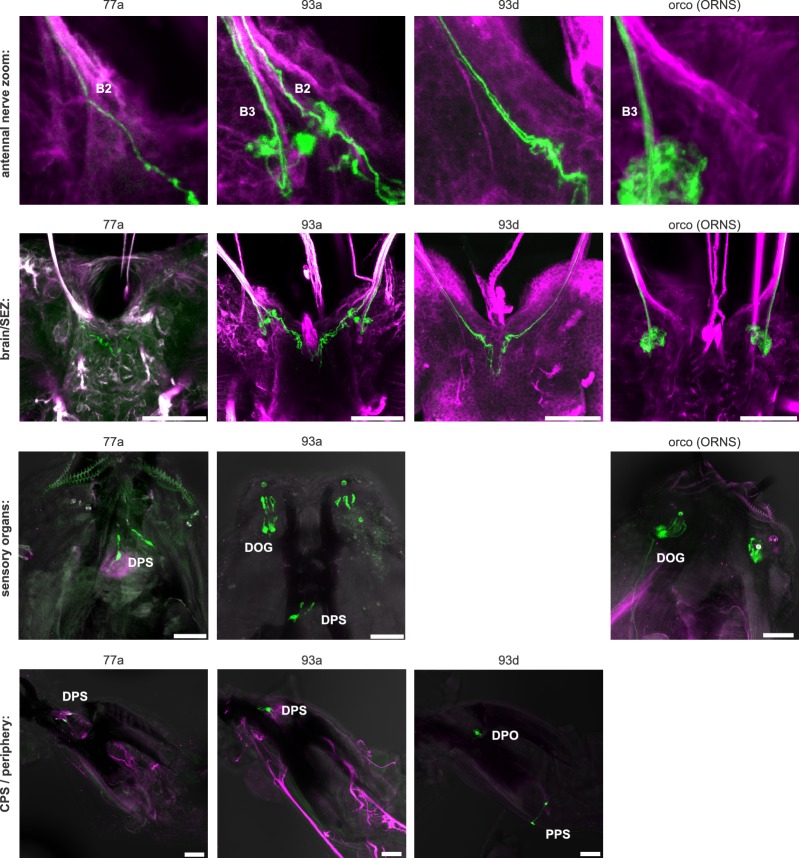
Gustatory receptor expression.Top row scale and all scale bars = 50 µm.